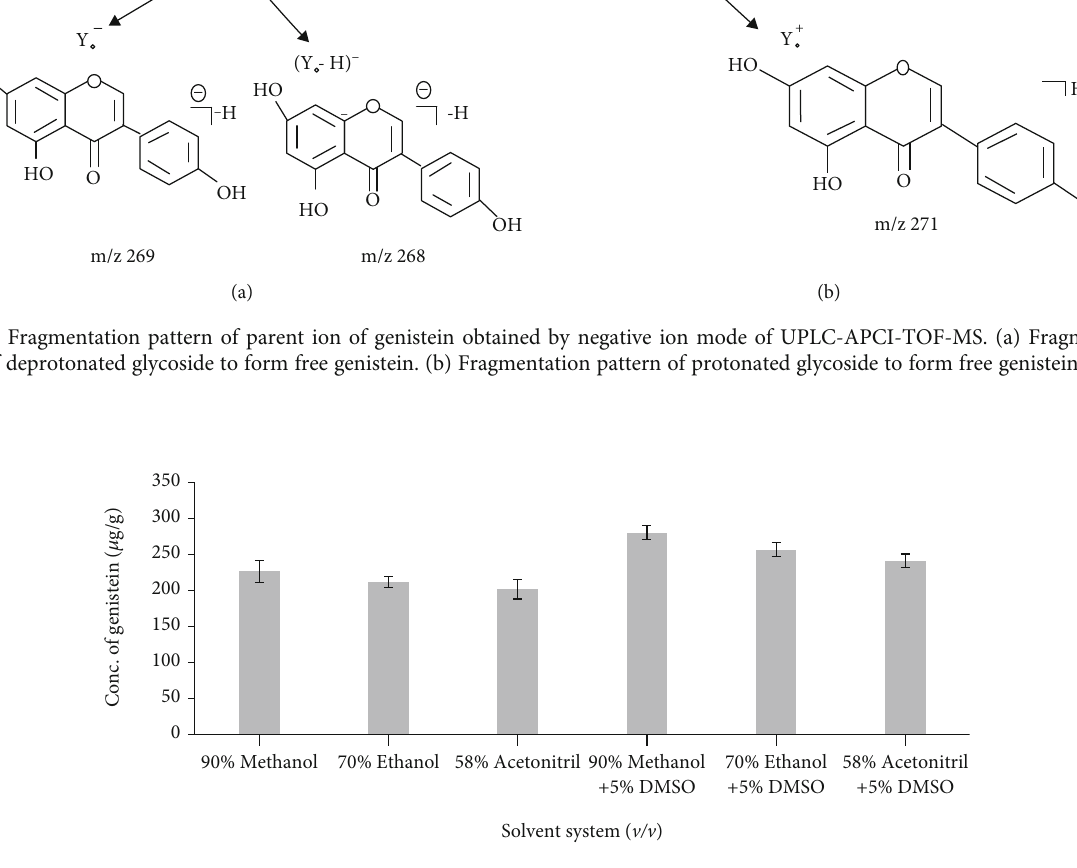
Figure 4: In fl uence of di ff erent solvent mixtures on Cuminum cyminum genistein content. (100mL of solvent, temperature 80 ° C and time 1h). (The bars show the mean values from three replicates ( n = 3 ) with the respective standard deviations).